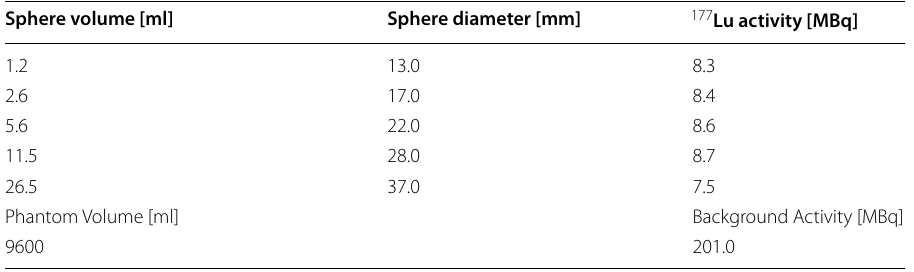
Table 5 The five spheres of the NEMA PET phantom with their respective activity and background are shown. Each of the value reported in this Table is the mean value of five different measurements, with an associated error of less than 1% Sphere volume